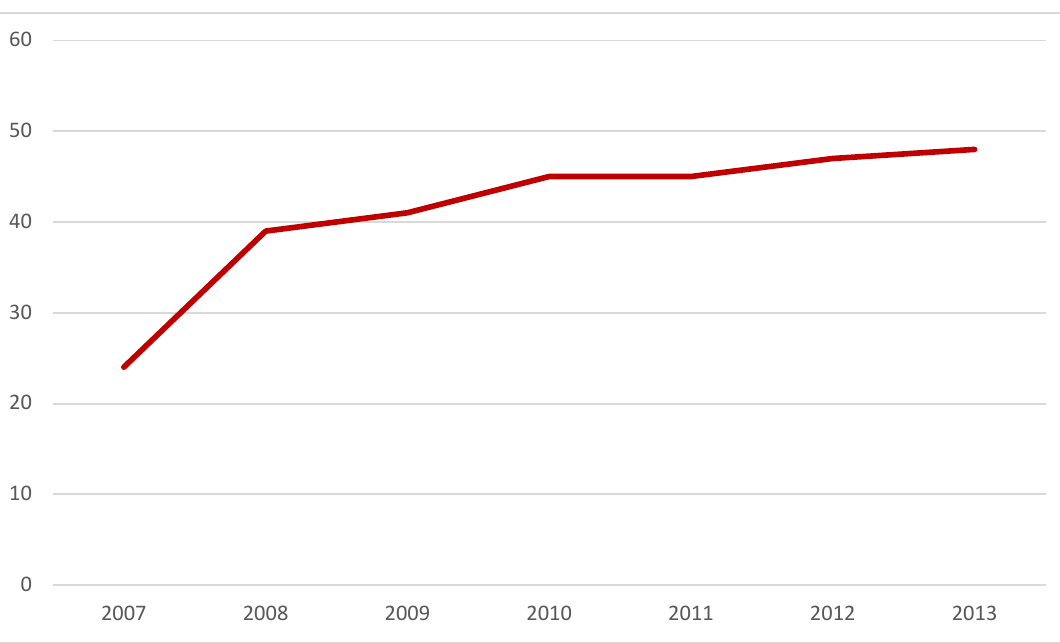
Note. Figure created by the author. Source data collected from the OCW-Universia site (http://ocw.universia.net) and captures of that website by the